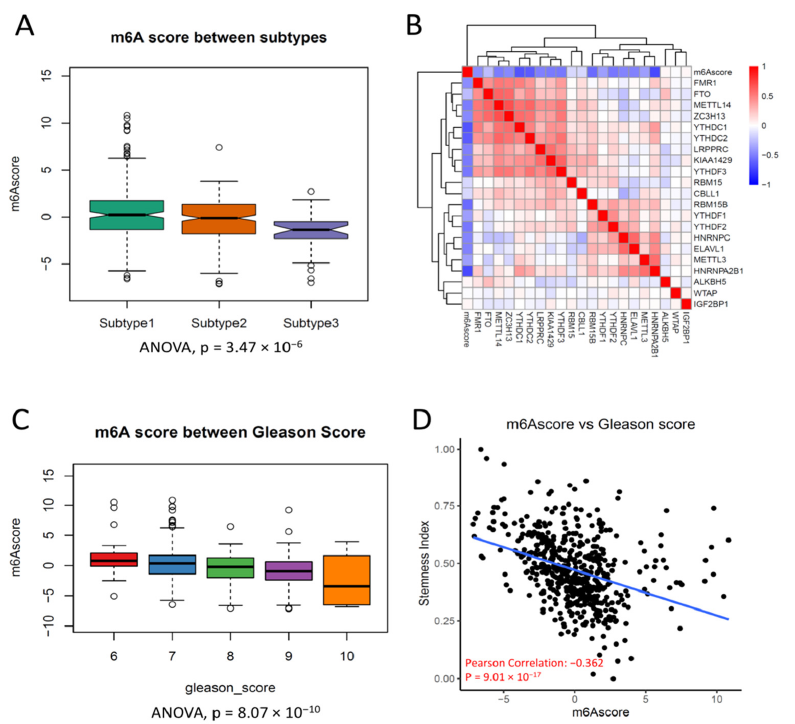
Figure 4. The m 6 A score is related to the Gleason Score and the stemness score. ( A ) Boxplot showing the different m 6 A scores between subtypes of m 6 A. Subtype 3 has the lowest m 6 A score. ANOVA, p = 3.47 × 10 − 6 . ( B ) Heatmap of the correlation between m 6 A regulators. The correlation coefficient is highlighted by color. ( C ) Boxplot showing that the m 6 A score is inversely associated with the Gleason score (ANOVA, p = 8.07 × 10 − 10 ). PCa with a higher Gleason Score has a lower m 6 A score. ( D ) m 6 A score is inversely correlated with the Stemness Index (Pearson Correlation, r = − 0.362; p = 9.01 × 10 − 17 ). To further validate the progression prediction for PCa by m 6 A score, we compared the m 6 A score between PCas with metastasis and non-metastasis. As expected, metastatic